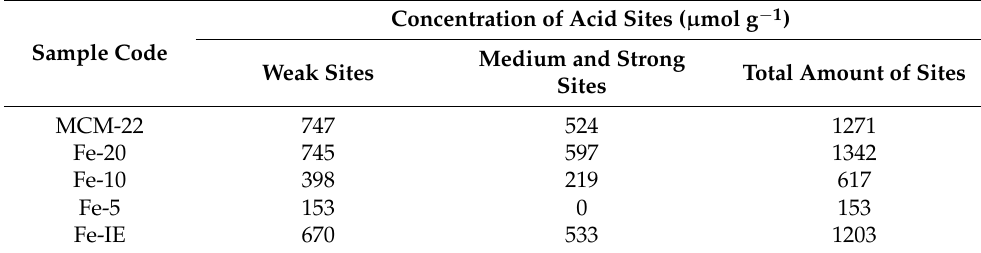
Figure 12. NH 3 -TPD profiles obtained for MCM-22 and the catalysts within 100–800 °C. Table 6. Density of the acid centers in the samples determined by NH 3 -TPD.